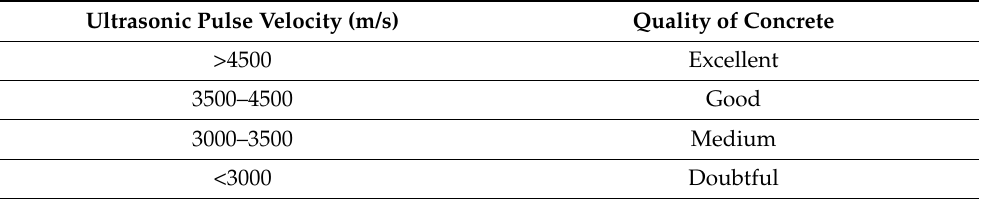
Table 8. Concrete quality according to